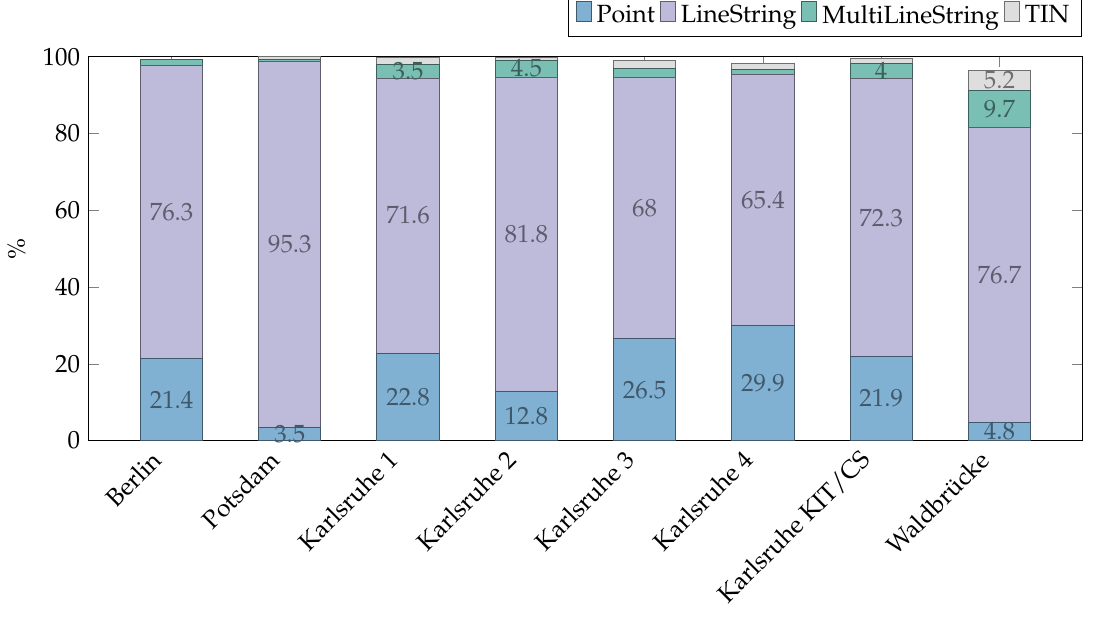
Figure 5. Proportions of the most frequent non-empty polygon intersection types.